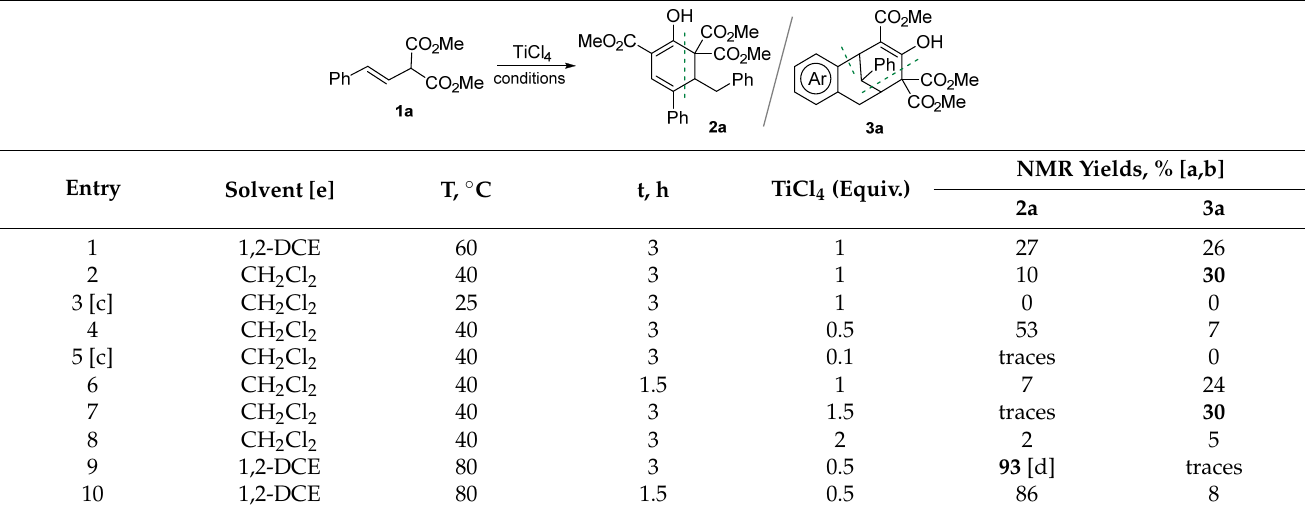
Table 1. Optimization of the reaction conditions for dimerization/elimination of β -styrylmalonate 1a .